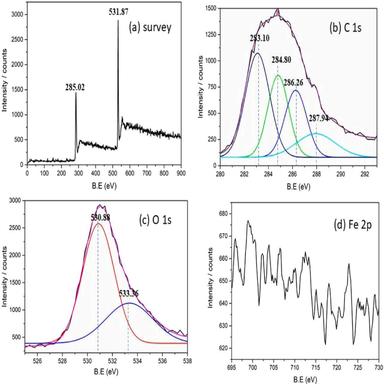
XPS Spectra of the Fe-GO Nanocomposite, including (a) Survey Spectra, (b) C 1 s Spectra, (c) O 1 s Spectra, and (d) Fe 2p Spectra.